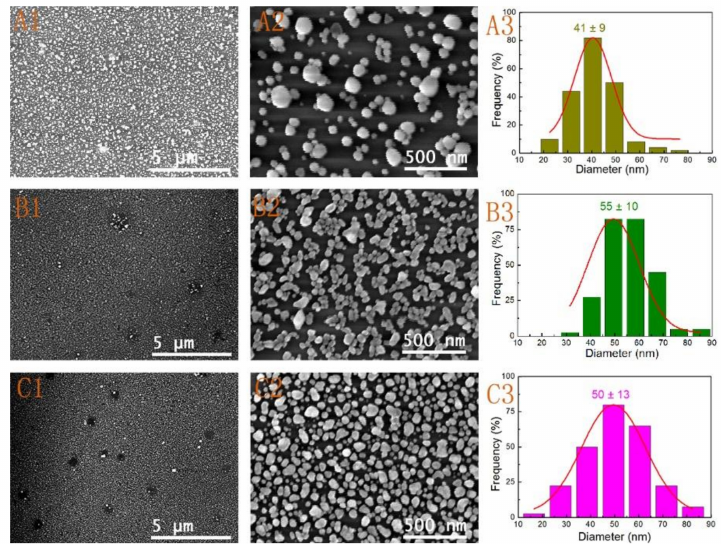
Figure 4. SEM images ( A1 , A2 , B1 , B2 , C1 , C2 ) and size distributions ( A3 , B3 , C3 ) of Au nanoparticle films formed by adding different amounts of reaction mixture after the substrates were activated with seed I: ( A1 – A3 ) 1 mL, ( B1 – B3 ) 2 mL, ( C1 – C3 ) 5 mL (All of soaking time was fixed at 12